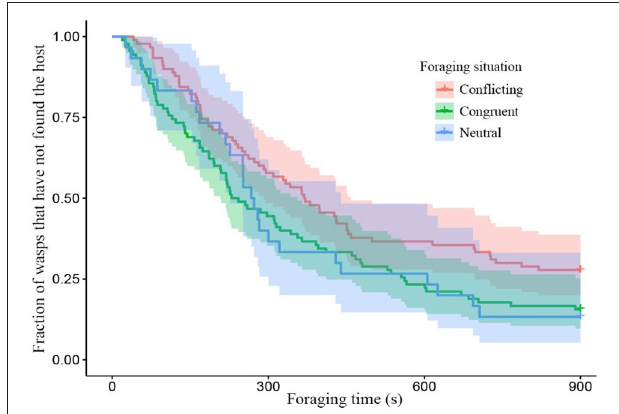
FIGURE 2 | Survival plot of the fraction of wasps which have not found the host with foraging time in different foraging situations. Colored areas around the lines show the 95% confidence interval (neutral n = 30, conflicting and congruent n = 90). Conflicting and congruent survival curves were significantly different ( z = − 2.38, p =